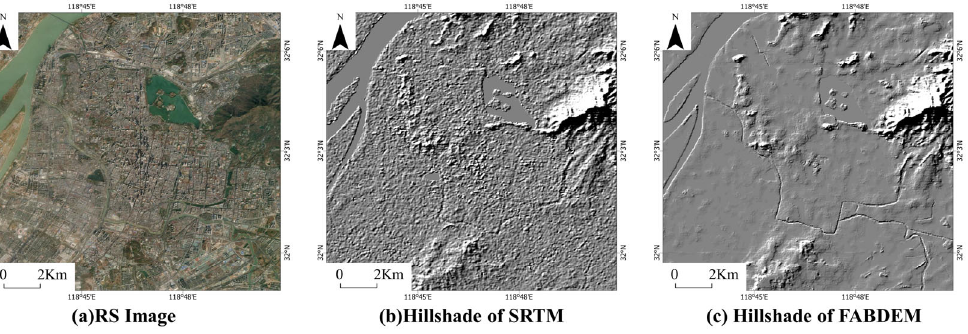
Figure 1. A comparison of the hillshade effect of SRTM ( b ) and FABDEM ( c ) with reference to Remote sensing images in the central area of Nanjing. ( a ) Remote sensing images in the central area of Nanjing.